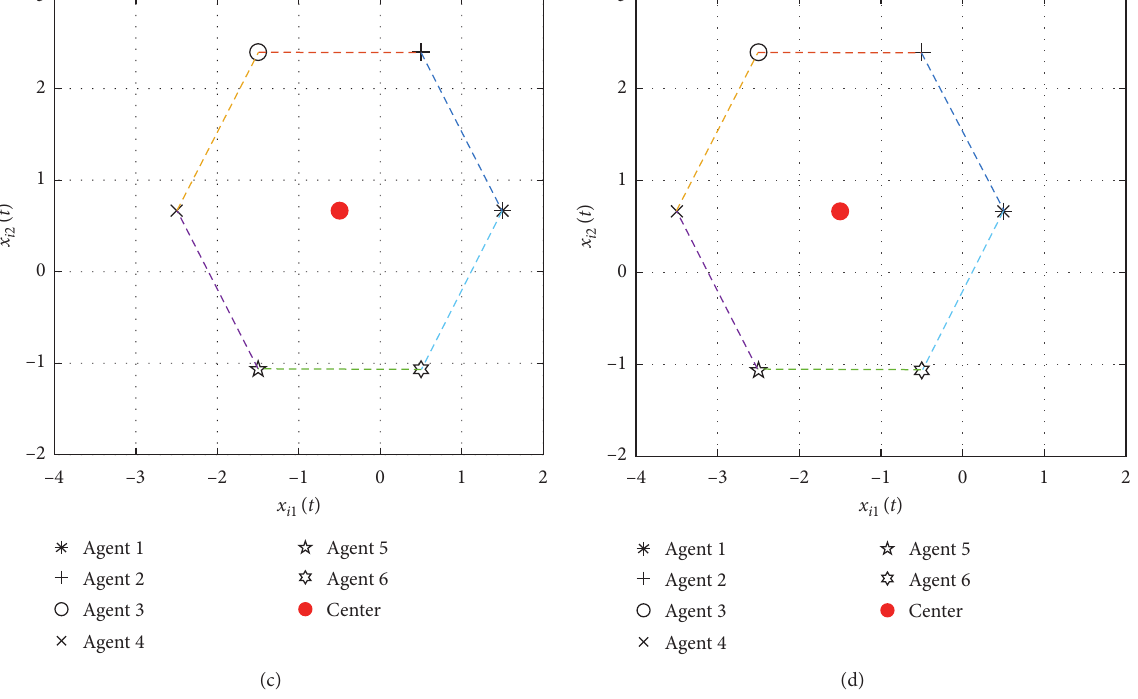
Figure 2: State snapshots for static whole motion. (a) t � 0s. (b) t � 14s. (c) t � 16 s. (d) t � 18s.